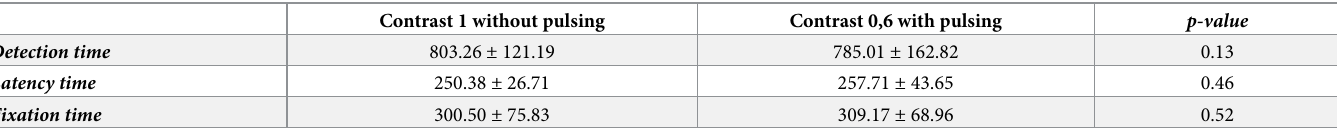
Table 5. Comparison between two options in LSF-20%.